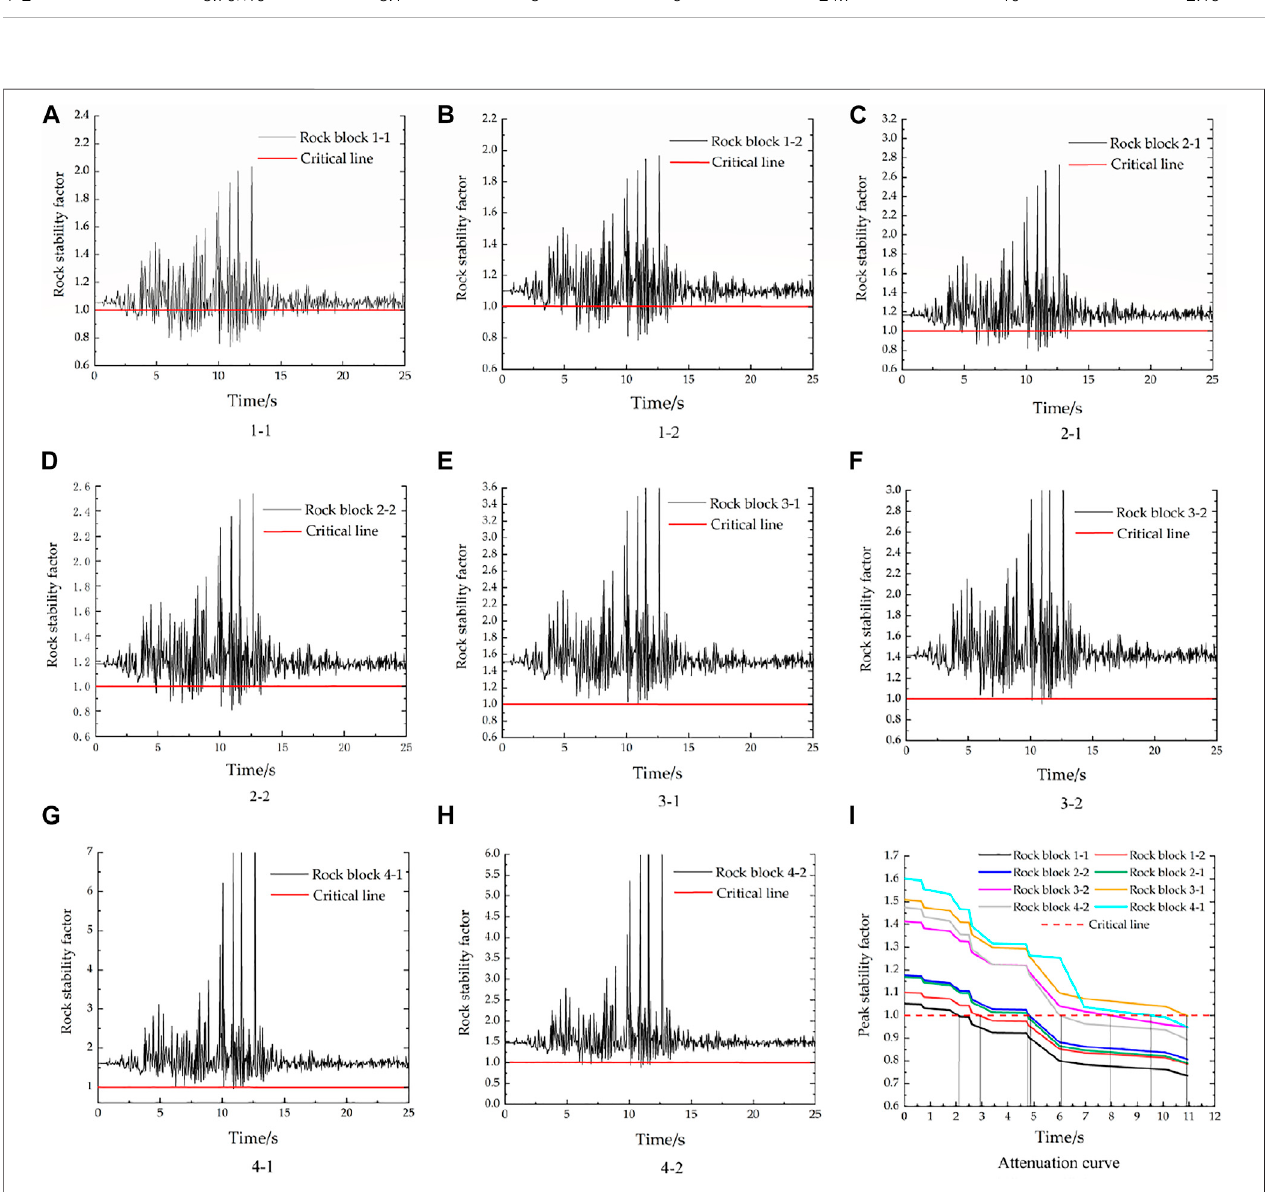
FIGURE 6 | (A – H) Time-history curve of seismic stability coef fi cient (I) and attenuation.